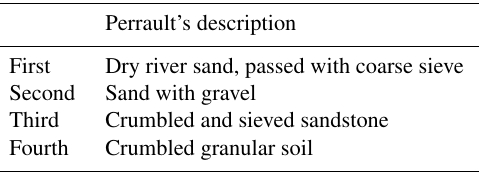
Table 3. Perrault’s description of the soils used during the first and second